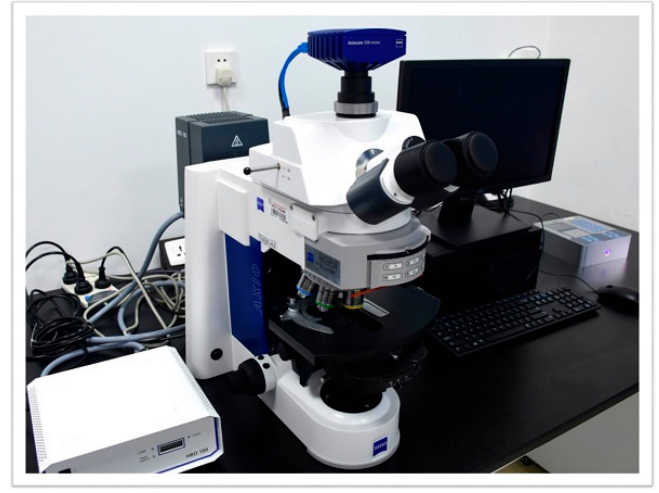
Figure 8. High-resolution fluorescence microscope in frontal position.